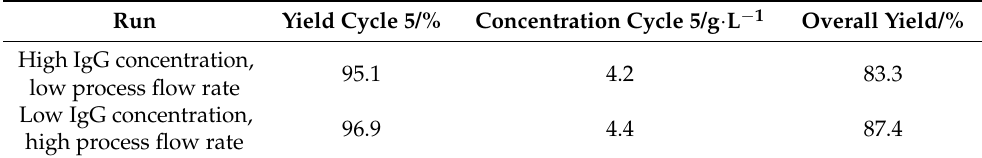
Table 5. Simulation results of iCCC for high and low feed concentrations, adjusting loading volume. Run Yield Cycle